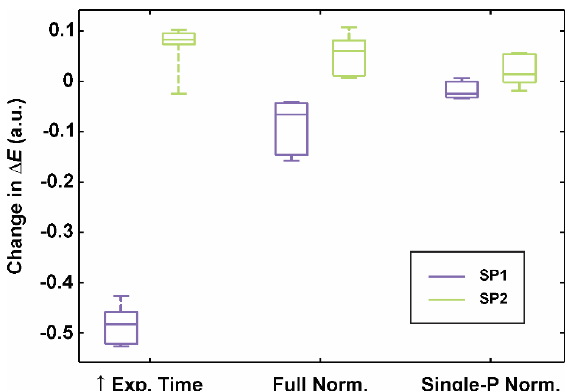
Figure 5. Changes in CIE76 color difference ( ΔE ) due to the modified color calibration procedures: increased exposure time reaching the sensor’ capacity limit (Exp. Time), full (Full Norm.), and single- point normalization (Single-P Norm.). A negative change marks the improvement in colorimetric accuracy. Boxplots: the central mark represents the median; the bottom and top box edges indicate the 25th and 75th percentiles, respectively. Whiskers extend to the most extreme data point.